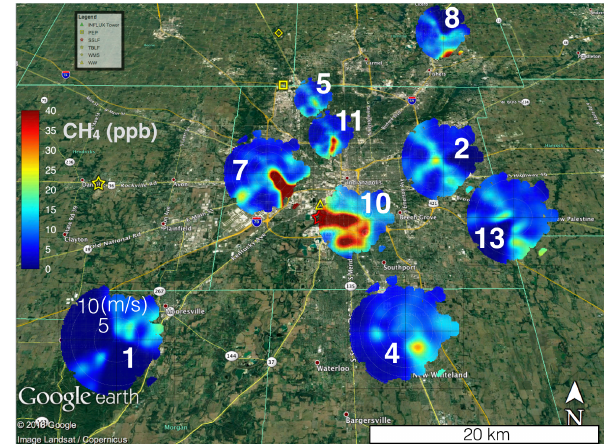
Figure 9. © Google Earth image overlaid with bivariate polar plots (Sect. 2.5) of the CH 4 enhancements at nine INFLUX towers in In- dianapolis using the criterion 1 background (Table 1) for the year 2016 over the afternoon (12:00–16:00LST). The wind speed scale is only labeled at site 1; other sites follow the same convention. The legend indicates known sources of CH 4 : Panhandle Eastern Pipe Line (PEP), South Side landfill (SSLF), Twin Bridges landfill (TBLF), Waste Management Solutions (WMS), and a wastewater treatment facility (WW). The known magnitudes of sources that are in Marion County (PEP, SSLF, and WW) are reported in Sect.